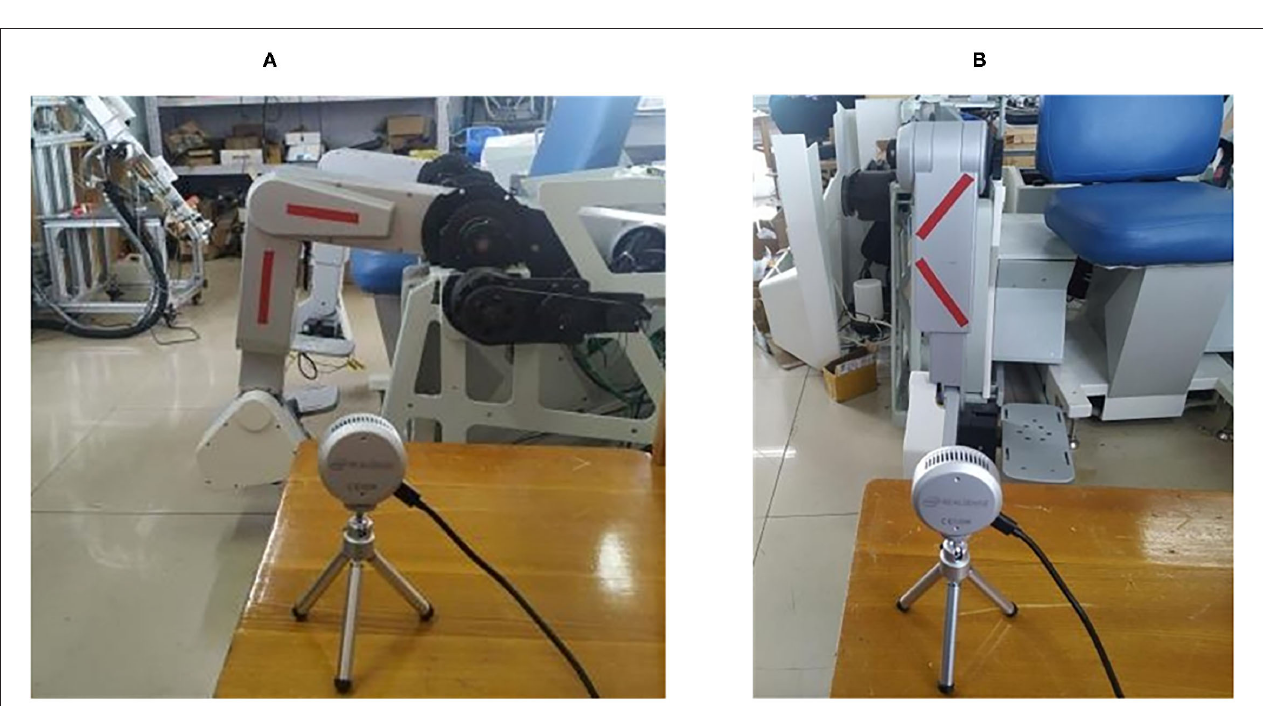
the mechanical leg mentioned above to verify the joint range of motion in the coronal plane. The position arrangement of the markers is shown in Figure 10B . In the experiment, the knee axis of the mechanical leg is equivalent to the human hip joint axis in the coronal plane. The calf of the mechanical leg is equivalent to the human lower limb. The calf from the mechanical leg is designed to move round and forth around the rotation knee joint axis many times while the thigh is still,